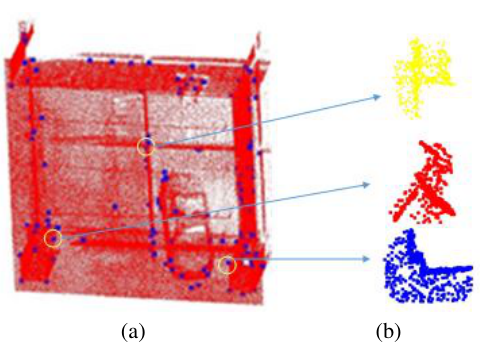
Figure 2. Data preprocessing. (a) Key points are extracted from the point cloud, (b) Local patches are extracted from the point